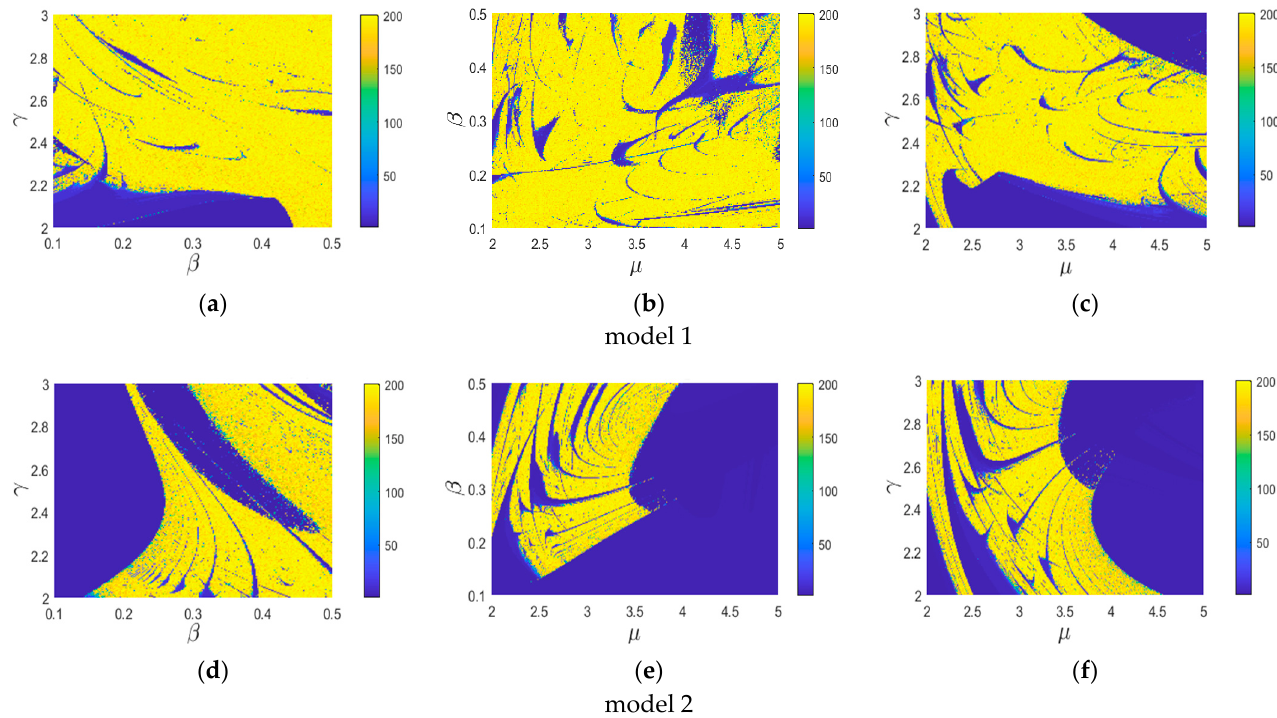
Figure 7. Plane screenshot of three-parameter bifurcation diagram: ( a ) µ = 3.5; ( b ) γ = 2.7; ( c ) β = 0.3; ( d ) µ = 3.5; ( e ) γ = 2.7; ( f ) β =